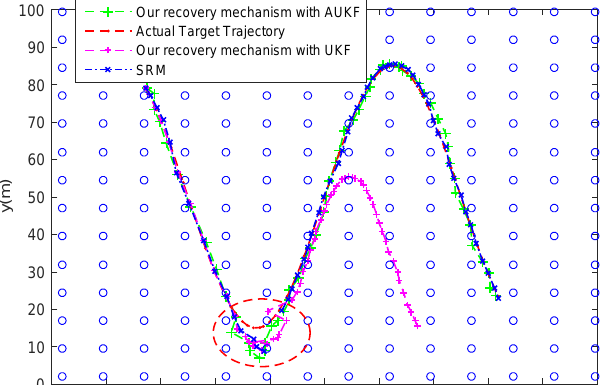
Figure 12. Tracking trajectories of the target under different recovery mechanism when the target suddenly change its speed or direction.